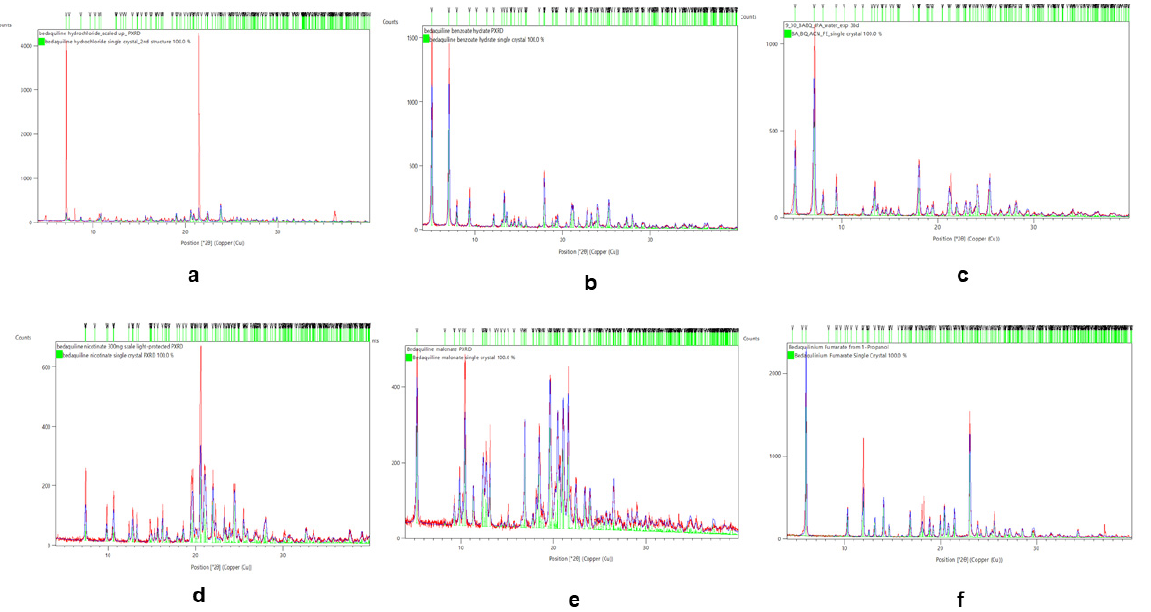
Figure 3. Rietveld refinements for bedaquiline salts confirmed that their PXRD values matched those of their corresponding individual single crystals. ( a ) HCl, ( b ) benzoate hydrate from acetone, ( c ) benzoate hydrate from 2-propanol-water antisolvent, ( d ) nicotinate, ( e ) malonate, ( f ) fumarate.